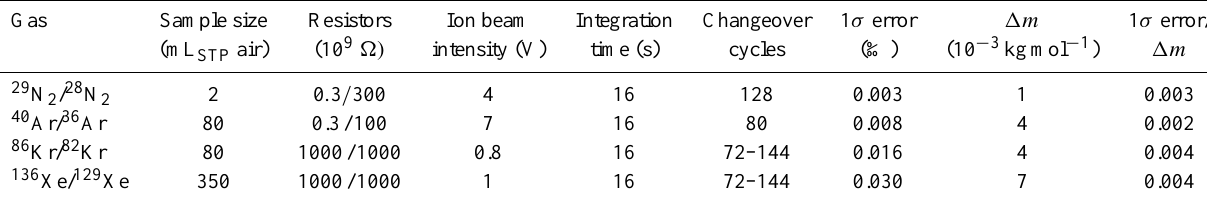
Table 2. Typical measurement parameters for